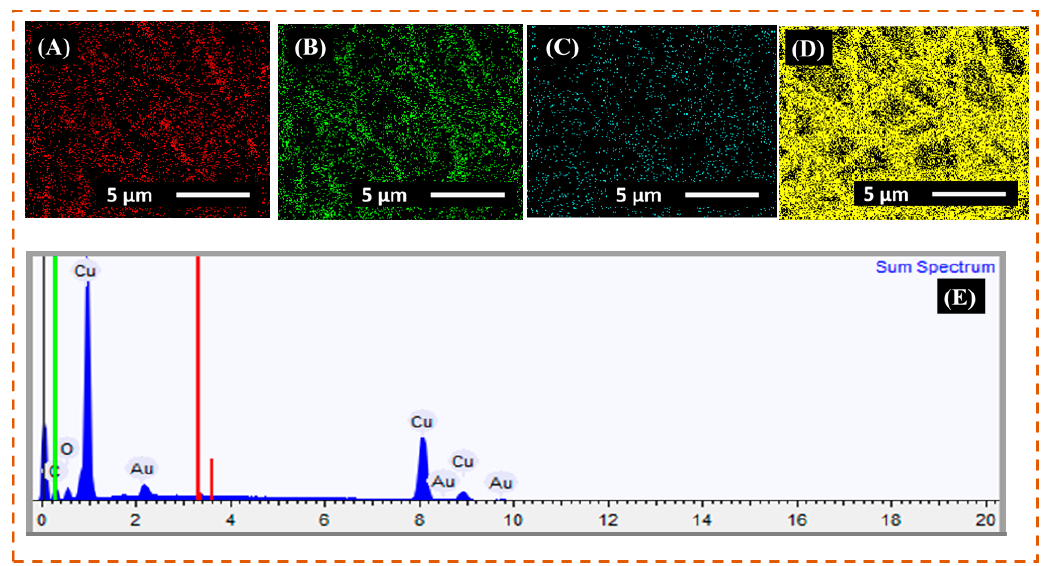
Figure 3. EDX elemental mapping and spectrum of copper-coated r-PET nanofibers. ( A – D ) show the oxygen, carbon, gold, and copper elemental mapping, respectively. And ( E ) EDX full spectrum of copper-coated r-PET nanofibers.